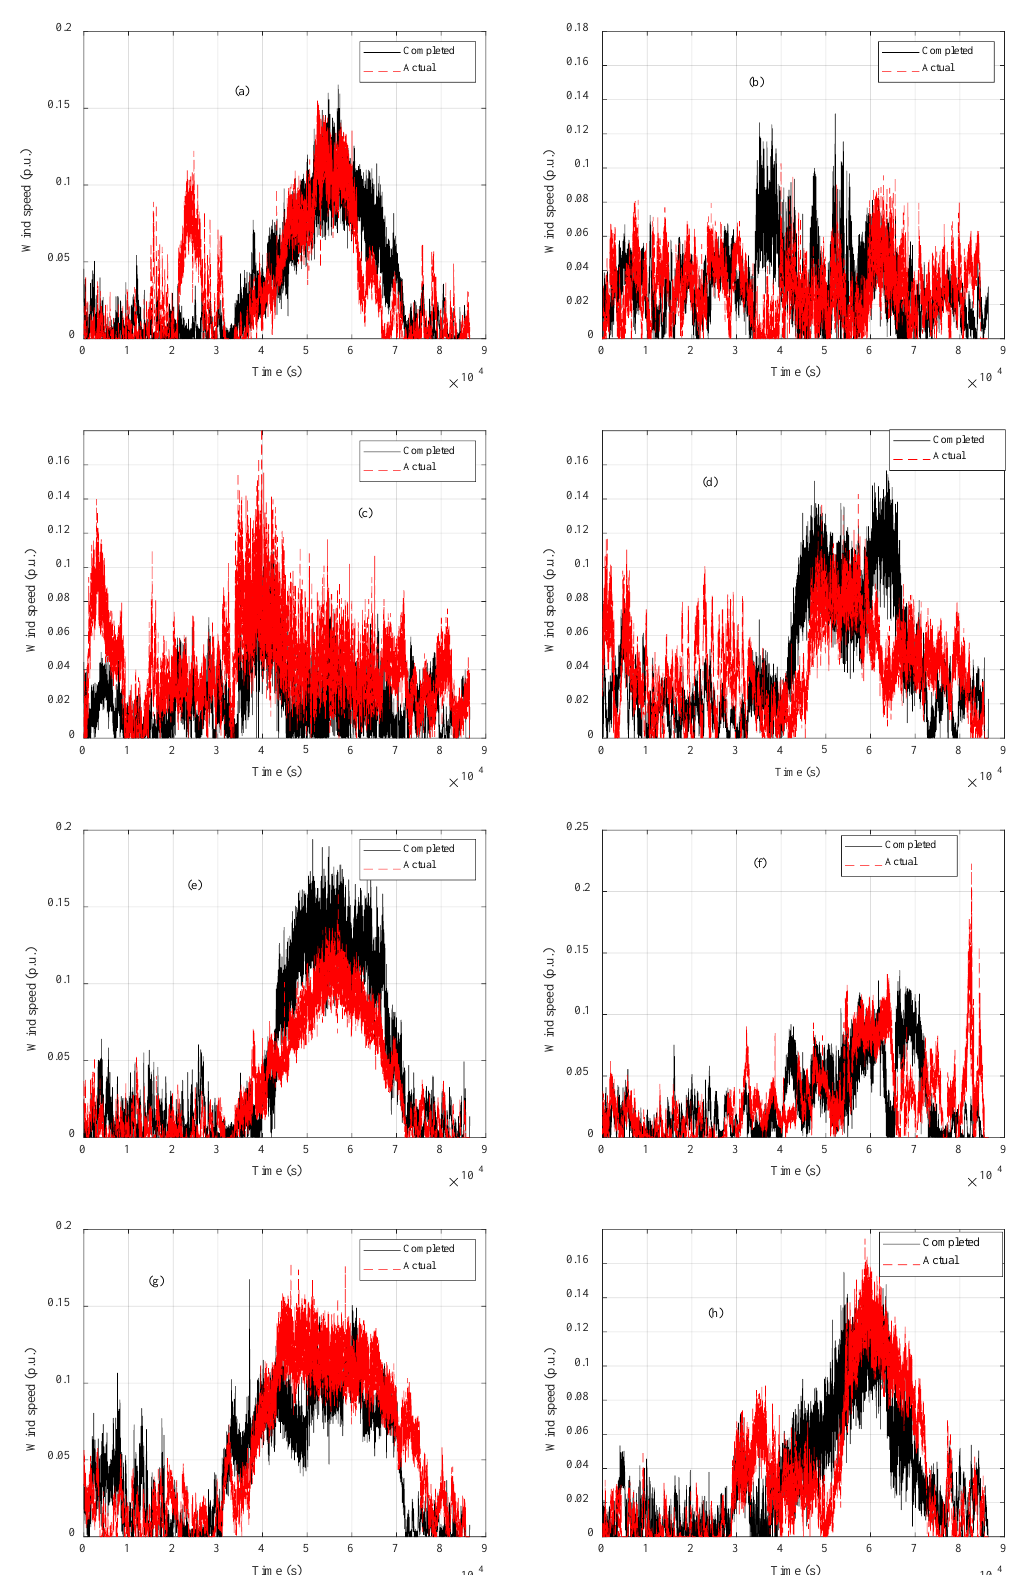
Figure 12. Completed and actual data of: ( a ) 01/10/2012; ( b ) 09/11/2012; ( c ) 09/01/2013; ( d ) 01/02/2013; ( e ) 23/04/2016; ( f ) 16/05/2013; ( g ) 09/06/2013; ( h ) 15/07/2013. The clustering was held with the UPGMC